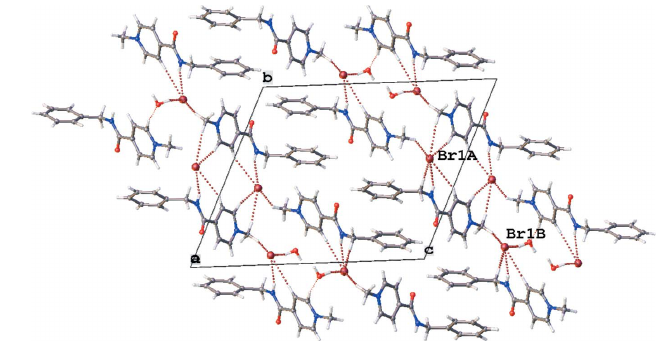
Figure 1 Molecular structure of the title compound, AmBr hemihydrate. Displacement ellipsoids are shown at the 50% probability level. C— H (cid:2)(cid:2)(cid:2) Br and N—H (cid:2)(cid:2)(cid:2) Br hydrogen bonds are indicated by dotted